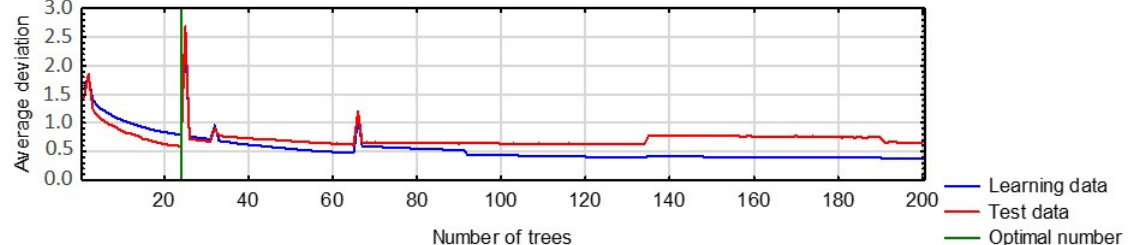
Figure A1. Model of the learning process using the enhanced decision tree method for the size classification of the variables under study. Source: own study.